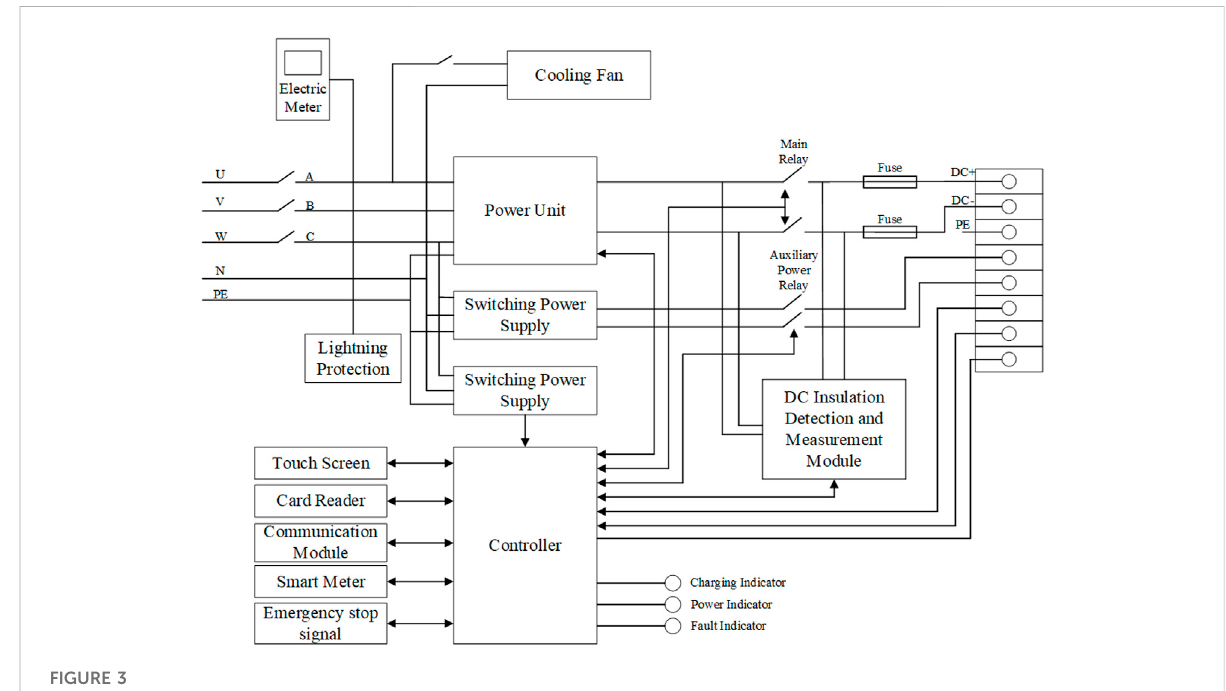
FIGURE 3 Electrical structure diagram of DC charger.